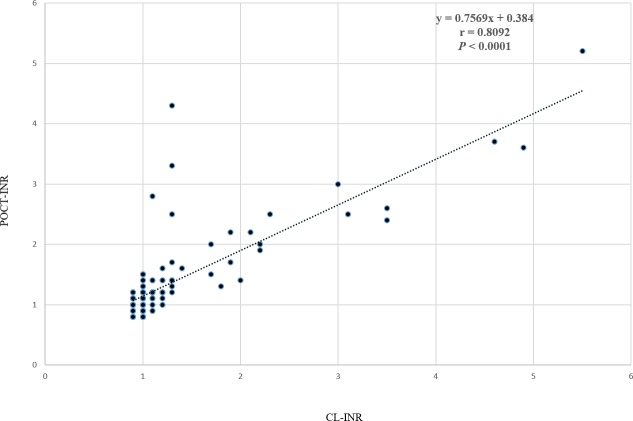
Correlation between CL-INR and POCT-INR.Fig 1 shows the correlation between the parameters CL-INR measured at the central laboratory with Behring Coagulation System (BCS XP) and POCT-INR measured at the neurology emergency department with HEMOCHRON Signature Elite® whole blood microcoagulation system.